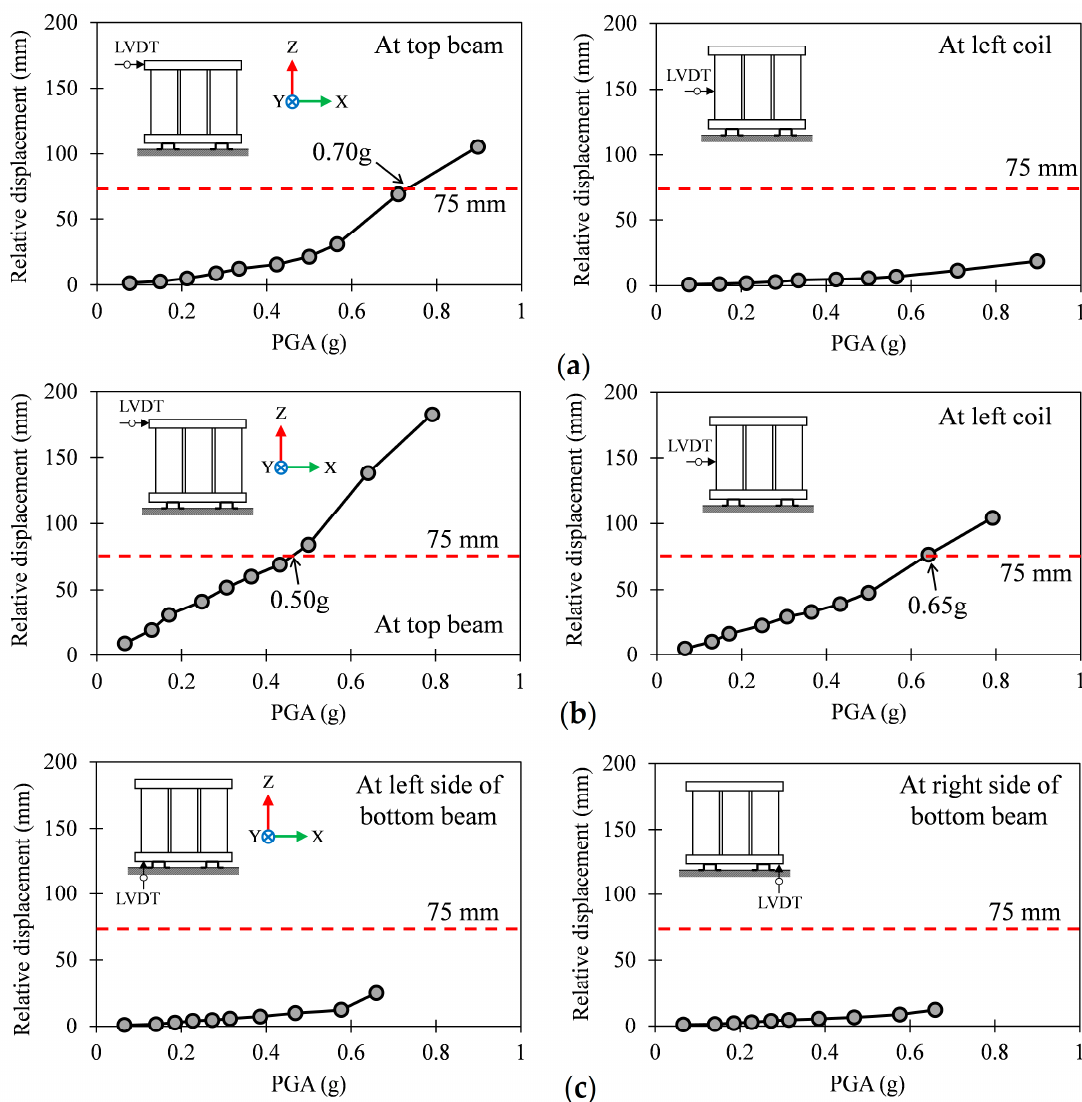
Figure 17. Maximum relative displacement of test specimen according to PGA. ( a ) X-direction; ( b ) Y-direction; ( c ) Z-direction.